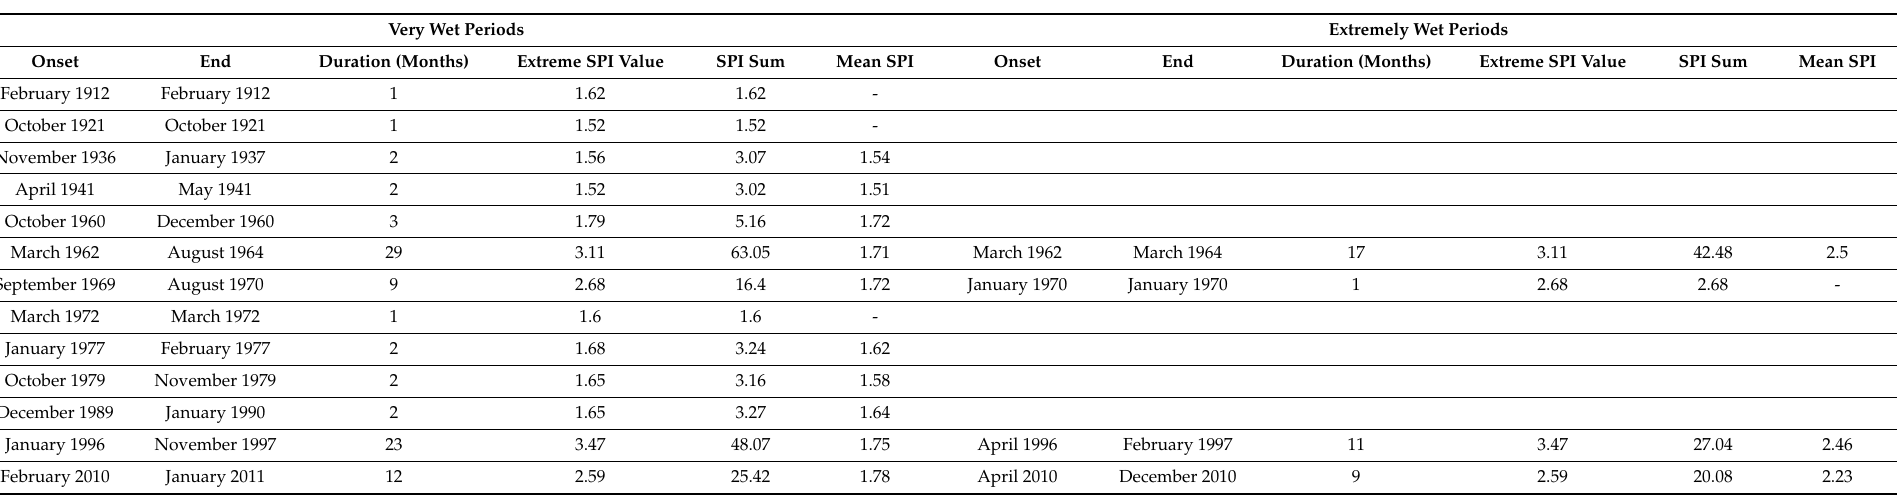
Table 4. Main characteristics of the wet periods identified in the studied basin for the period (1910/11–2017/18). Very Wet